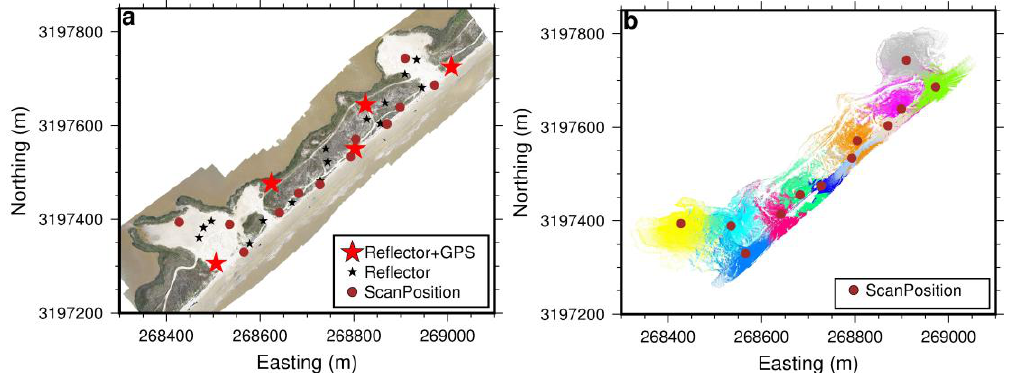
Figure 4. ( a ) Locations of reflectors and scanners used for collecting TLS datasets for the case study on 29 April 2018; ( b ) point clouds from 12 individual scans. The coordinates refer to the Universal Transverse Mercator (UTM) 15R system.